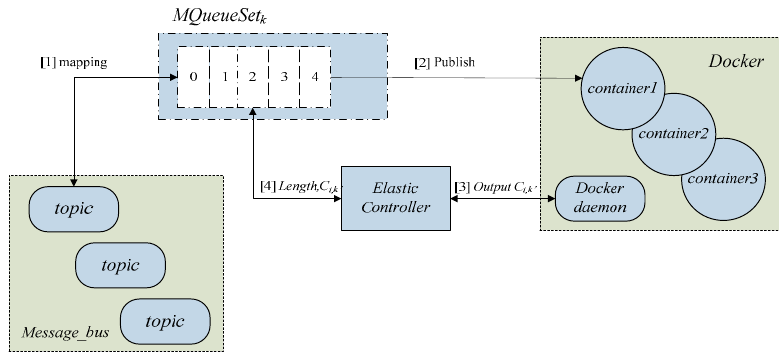
Figure 3. Elastic management model.